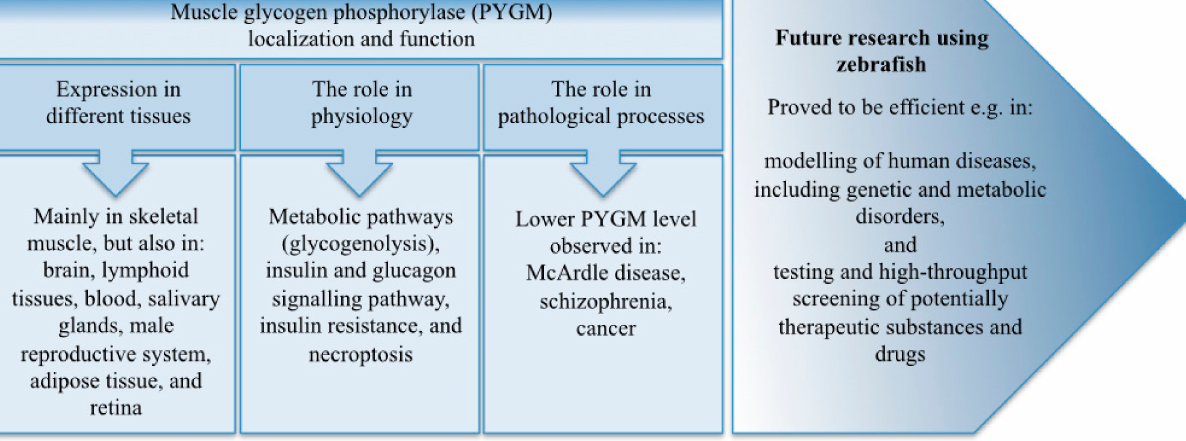
Figure 4. Muscle glycogen phosphorylase (PYGM) localization and function. The summary of the topics discussed in the